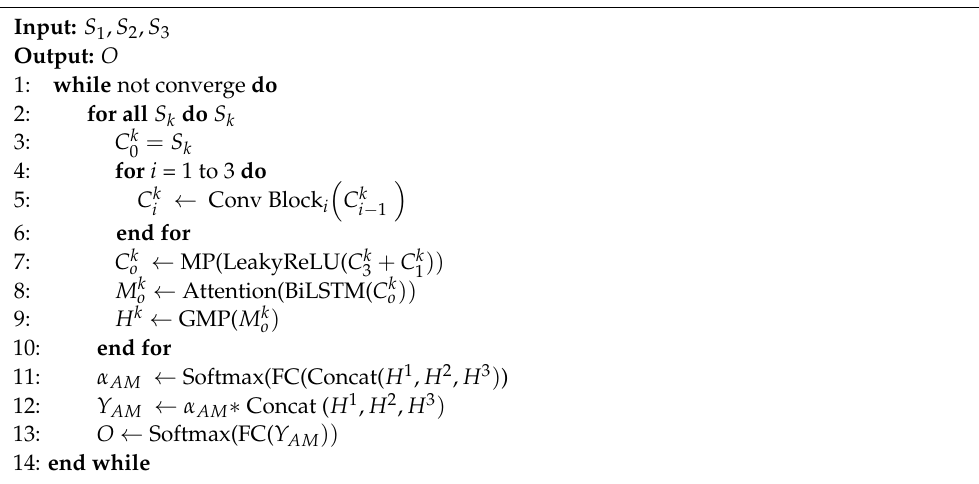
Algorithm 2. The procedure of